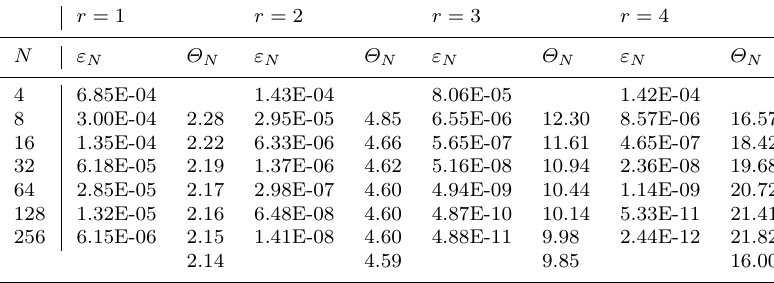
Table 3. Numerical results for problem (5.6)– (5.7) with m =